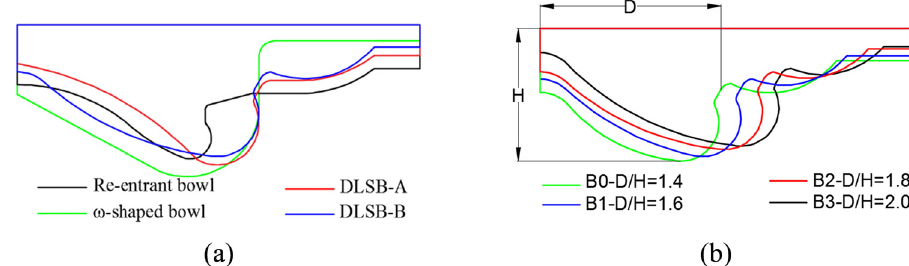
Figure 3: Bowl geometries. ( a ) Di ff erent bowl shapes and ( b ) di ff erent diameter - depth ratios of